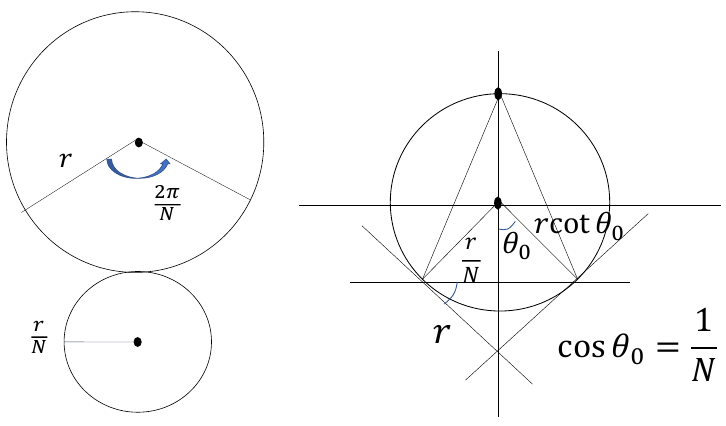
Figure 2 . The left panel shows the net of a cone cut out around the C = Z N singularity from T 2 = Z N , whereas in the right panel, the cone cut out by T 2 = Z N and a section of embedded subpart of S 2 with radius r are p 2 2